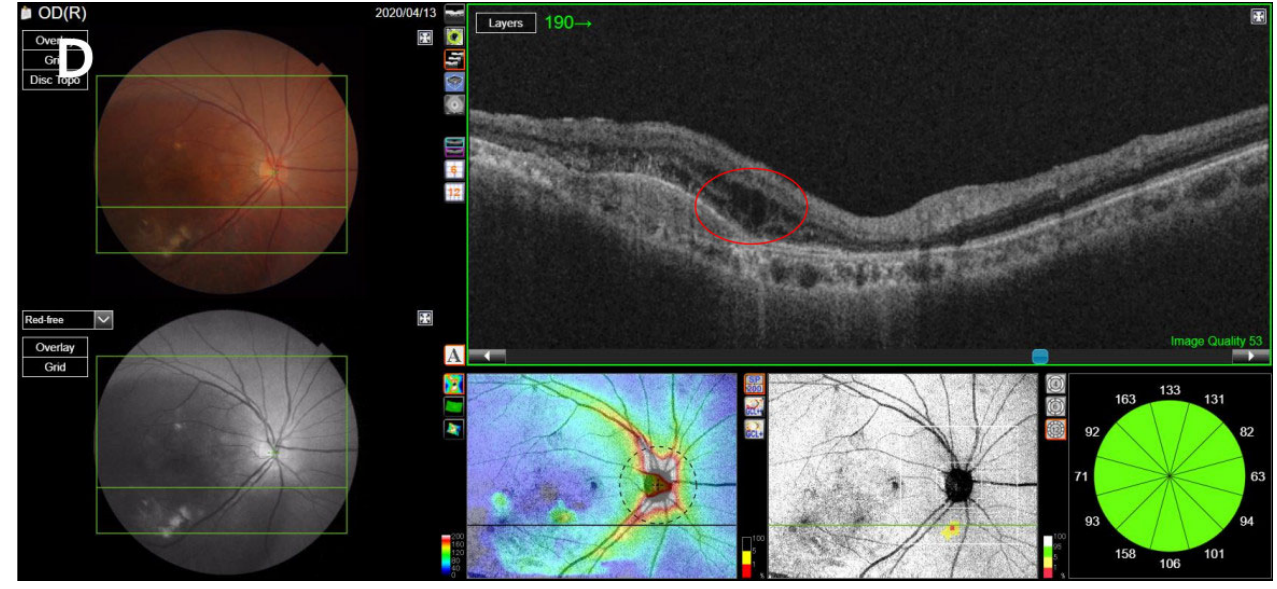
Figure 1. Measurement of SRF, PED, SHRM, and IRF. ( A ) The maximum SRF height was measured as the maximum distance between the outer retina and the hyperreflective line of the retinal pigment epithelium on the OCT image, using the caliper tool using IMAGEnet software. ( B ) The maximum PED height was measured as the maximum distance between the inner surface of the Bruch membrane and the outer surface of the retinal pigment epithelium. ( C ) Presence of SHRM, which is a morphological feature seen on OCT as hyperreflective material located external to the retina and internal to the retinal pigment epithelium. ( D ) Presence of IRF, which appears as dark cystic accu ‐ mulations of fluid above the outer plexiform layer. SRF, subretinal fluid; PED, pigment epithelial detachment; SHRM, subretinal hyperreflective material; IRF, intraretinal fluid; OCT, optical coher ‐ ence tomography.